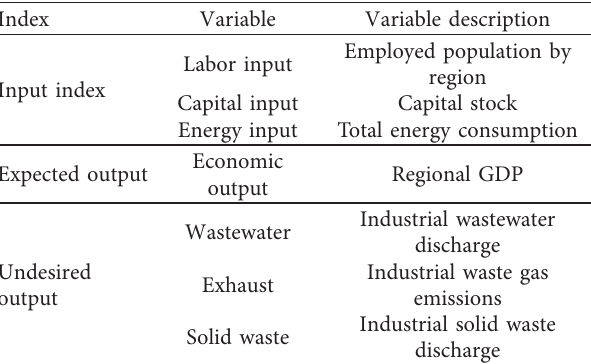
Table 1: Green economic efficiency measurement